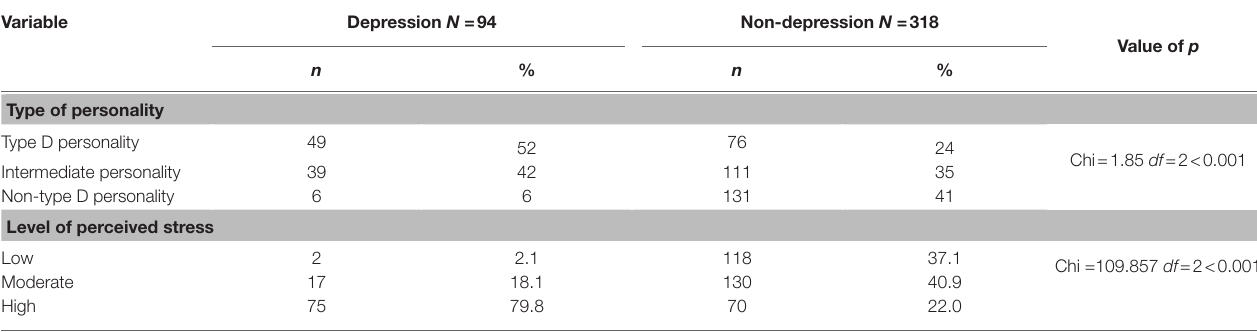
TABLE 6 | The prevalence of depression among the studied group of teachers, including type of personality and the level of perceived stress.